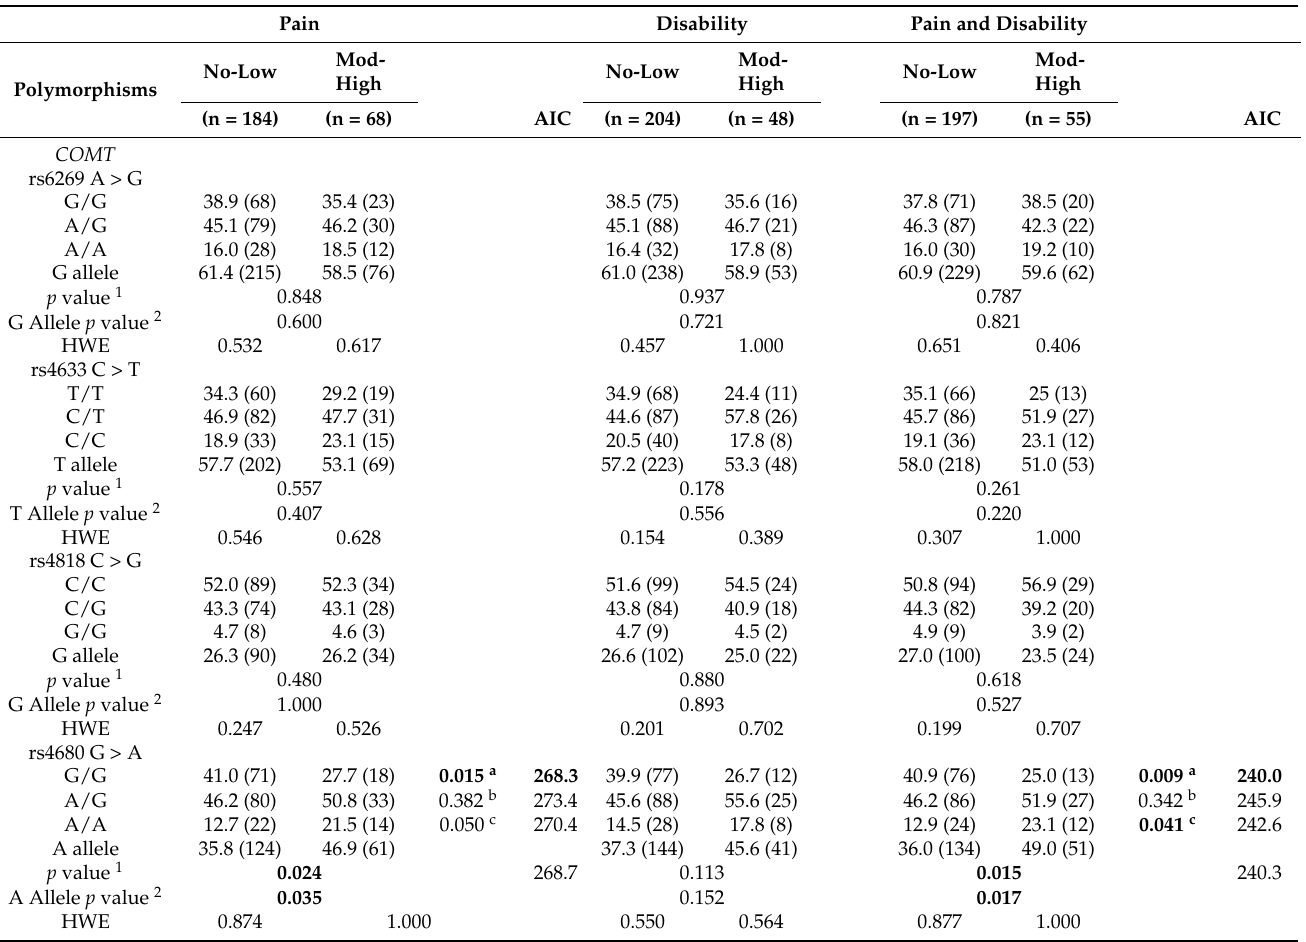
Table 1. Genotype and minor allele frequency distributions, of the COMT (rs6269 A > G; rs4633 C > T; rs4818 C > G; rs4680 G > A) polymorphisms between groups for pain, disability and combined (pain and disability)